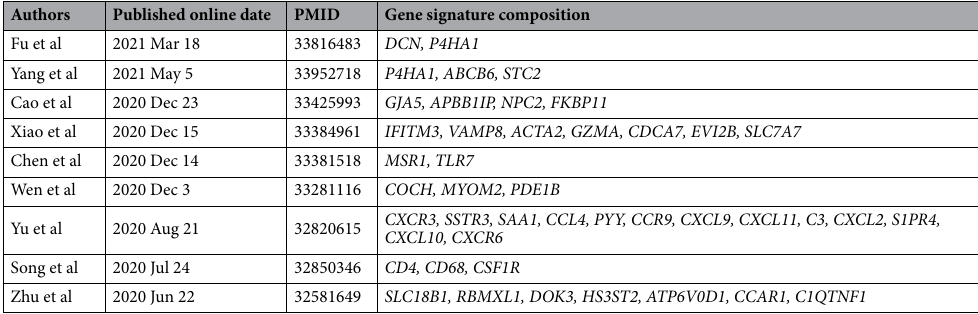
Table 3. Candidate research for comparison to our signature. PMID PubMed